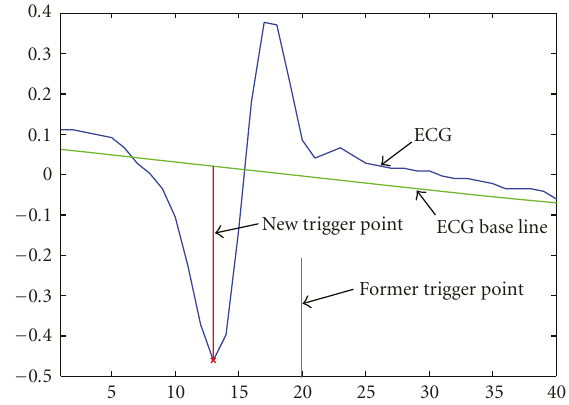
Figure 5: Adjustment of the position of the R -peak: the new trigger point is set to the place, where the di ff erence between the ECG and its base line is